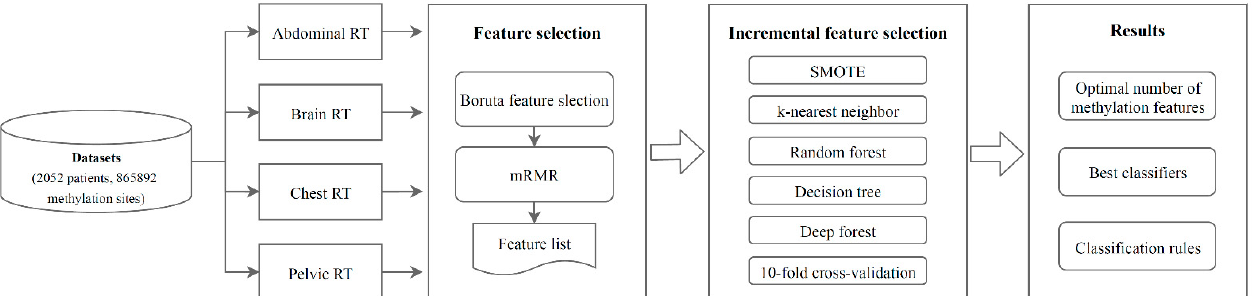
Figure 1. Computational workflow of this study. The methylation dataset was acquired in four sections from a public database: abdominal RT, brain RT, chest RT, and pelvic RT. The methylation features in each methylation profile were filtered and ranked using the Boruta feature selection and mRMR methods. The IFS method used the resulting feature list to identify the optimal number of features and develop the best classifiers and classification rules by combining SMOTE and classification algorithms.